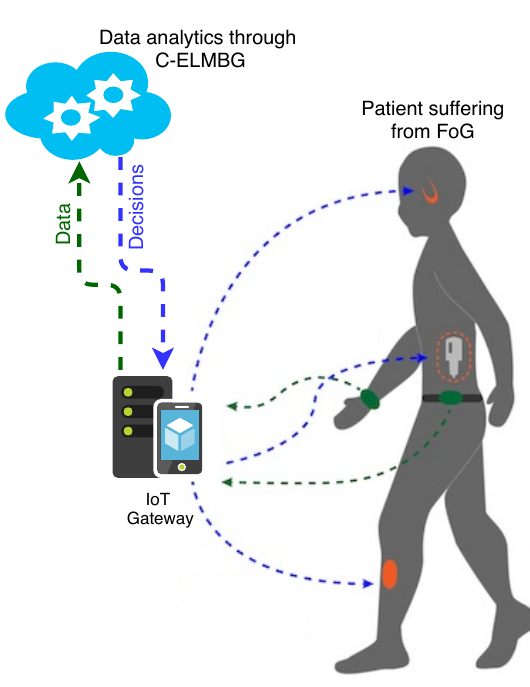
Figure 2. Online FoG detection through body-mounted